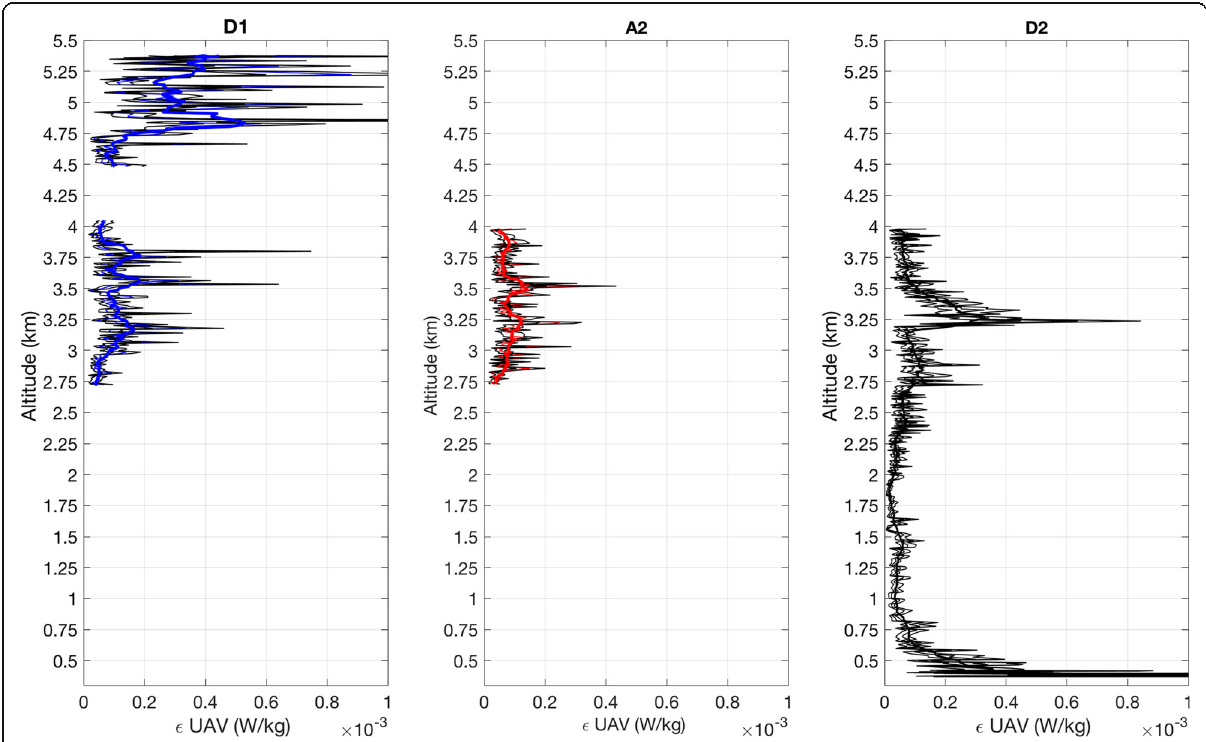
Fig. 16 Vertical profiles of ε UAV during D1 ( left panel ), A2 ( middle panel ), and D2 ( right panel ) of UAV 17. Thick lines show 11-point (55 s) running means. The thin black lines show the lower and upper bounds on the estimated ε UAV